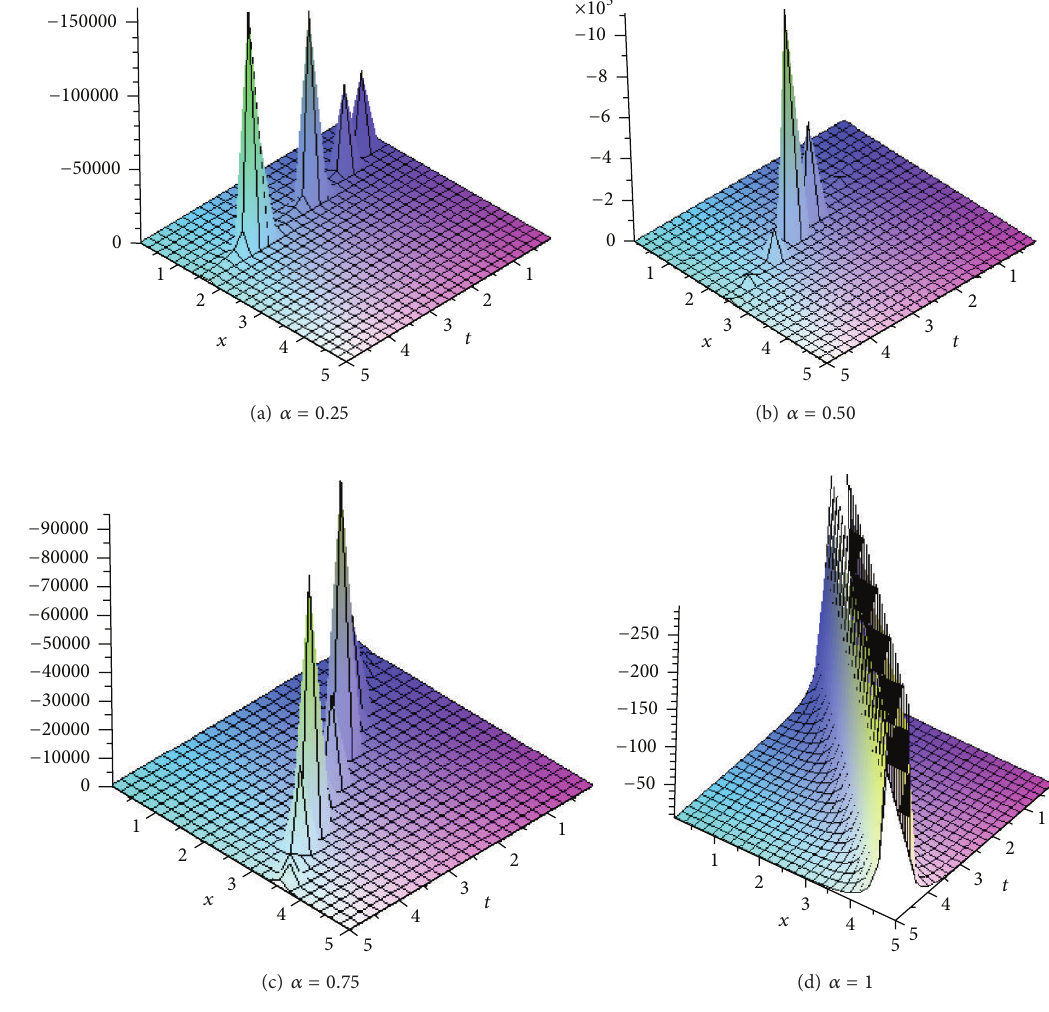
Figure 1: (a)–(d) show the singular soliton solution for 𝑢 2 1 for different values of